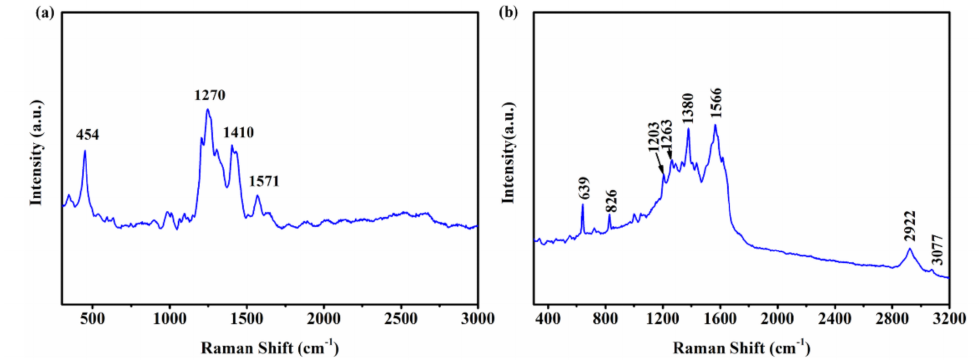
Figure 9. ( a ) SERS spectra of DOX (10 µ M); ( b ) SERS spectra of metvan (10 µ